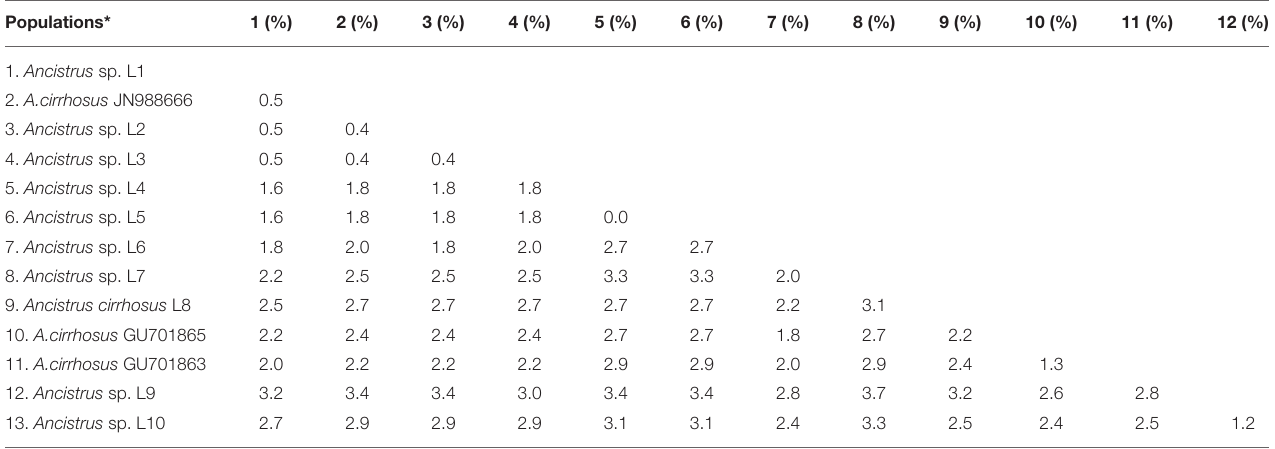
TABLE 2 | Uncorrected pairwise distances between the mitochondrial COI sequences of the Ancistrus populations from the Paraná basin. Populations* 1 (%) 2 (%) 3 (%) 4 (%) 5